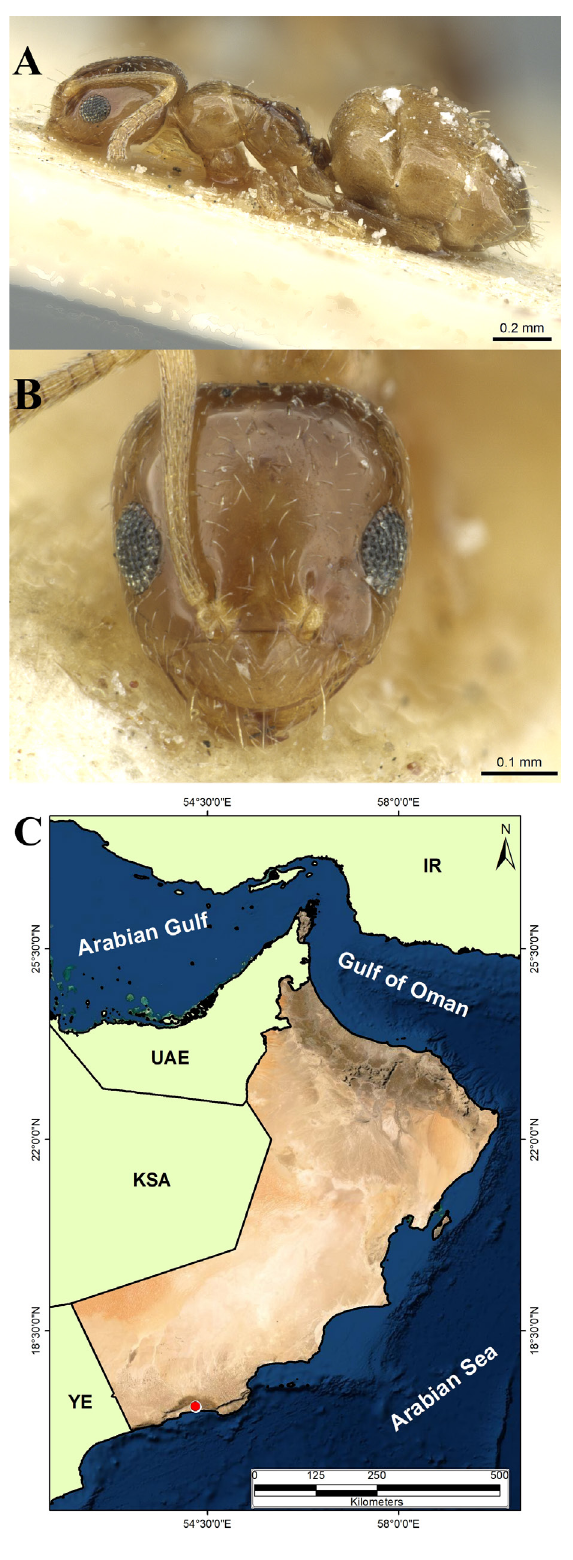
Fig. 24. Plagiolepis barbara Santschi, 1911, worker (CASENT0912424, AntWeb.org (Zach Lieberman)). A . Body in profile. B . Head in full-face view. C . Distribution